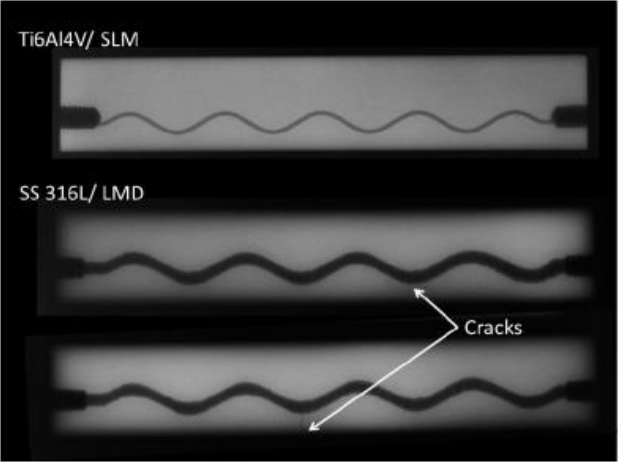
Figure 3. Eddy current (EC) signals from a normalized impedance plane diagram showing the defect detection in SLM2.